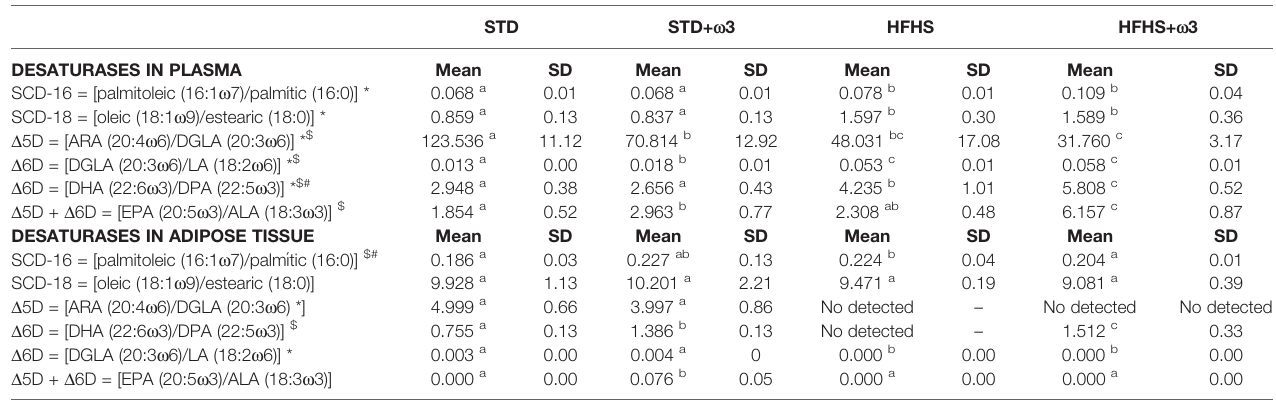
TABLE 3 | FAD indexes from total fatty acid data of plasma and white adipose tissue calculated as product/precursor ratio.